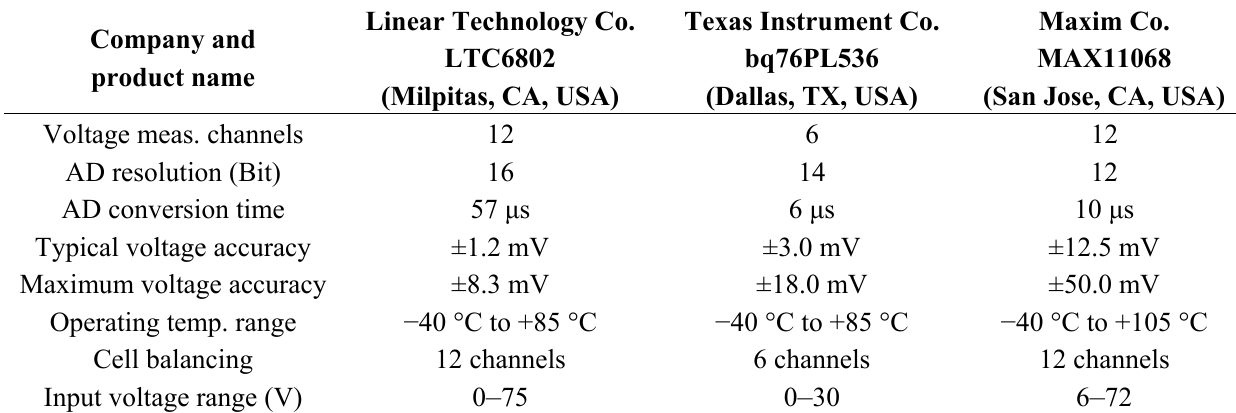
Table 9. The accuracy information comparison of three typical voltage sensors.